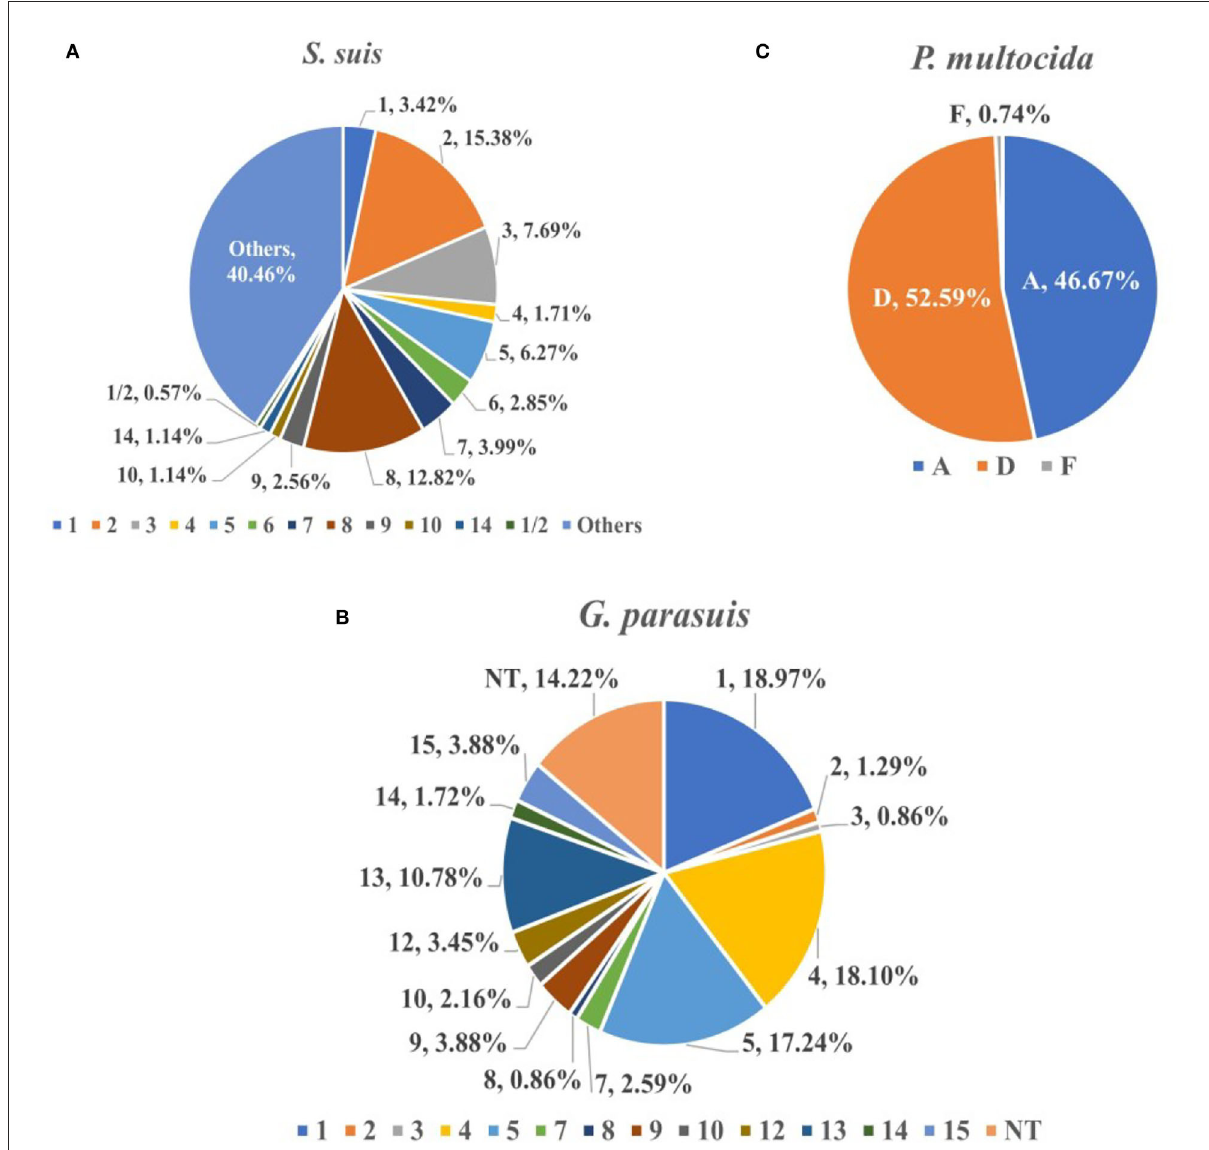
FIGURE3 The proportion of different serovars (serogroups) of S. suis (A) , G. parasuis (B) , and P. multocida (C). S. suis ( n = 351), G. parasuis ( n = 232) and P. multocida ( n = 135).